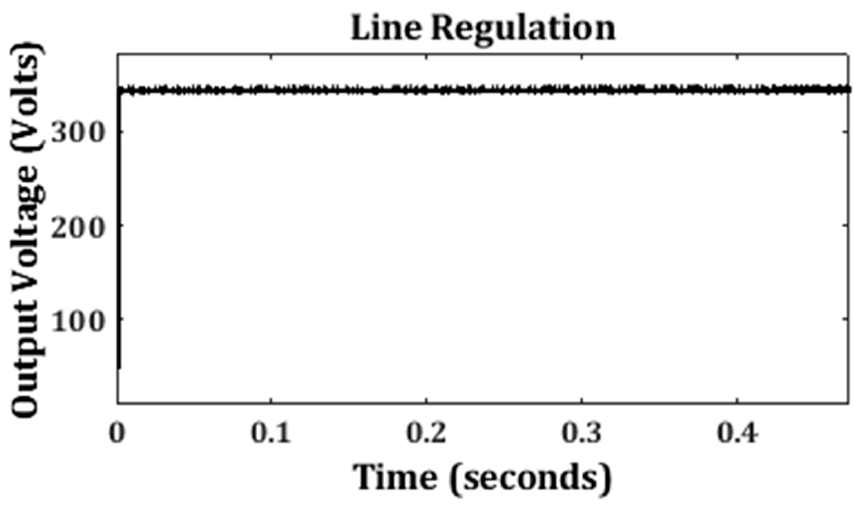
Figure 44. Battery terminal voltage in volts.